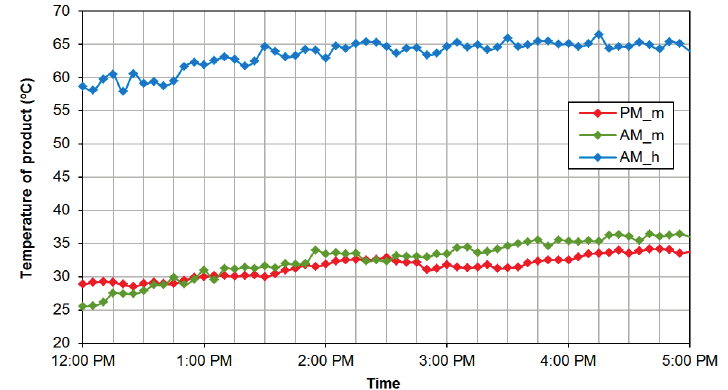
Figure 8. Temperature variation for